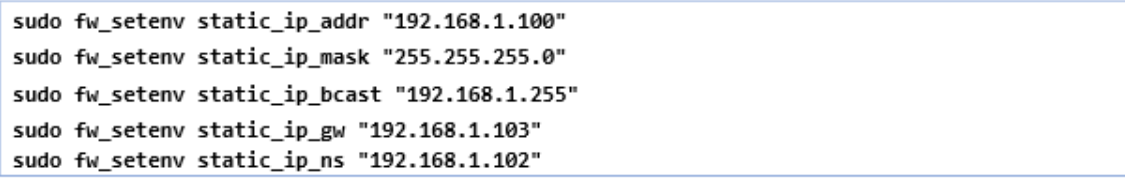
Figure 15. Identification and setting of the necessary IPs.